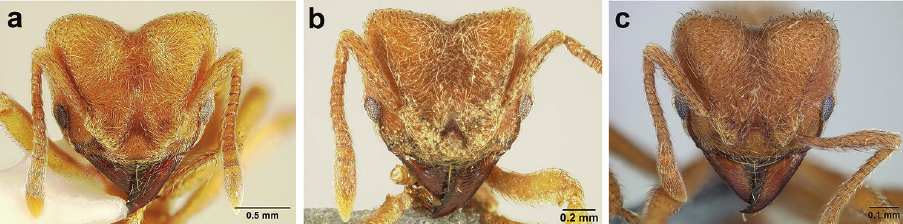
Figure 37. S. mayri worker variation; head, full-face view. a mayri worker from Brazil, Amazonas (USNMENT00444066) b mayri worker from Brazil, Bahia (USNMENT01125172) c mayri worker from Colombia, Meta